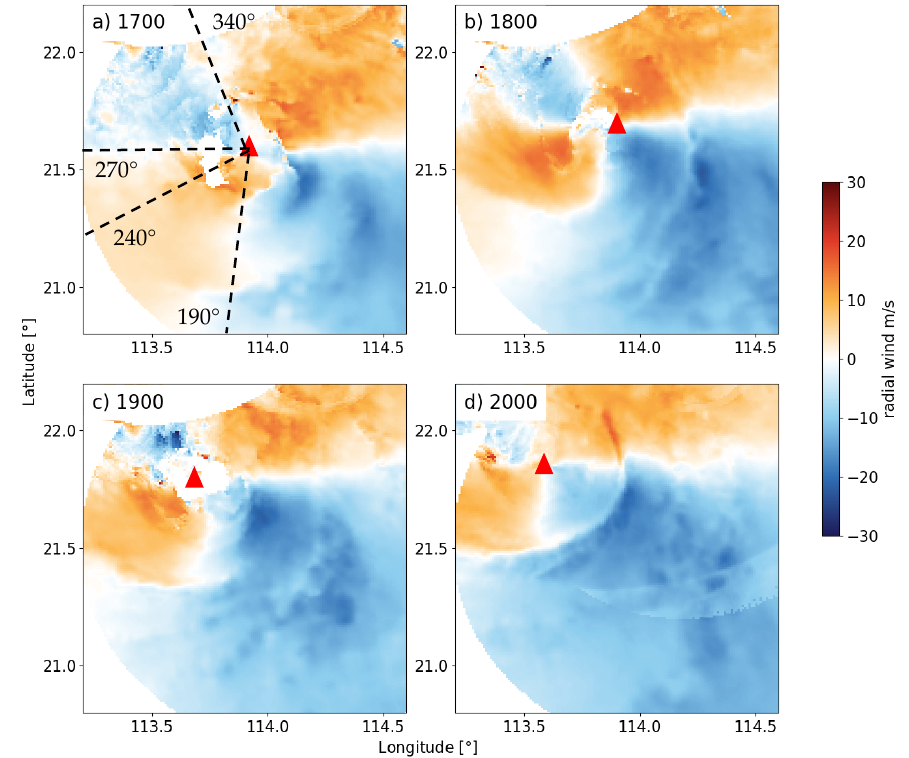
Figure 9. Radial wind calculated based on the horizontal wind at 4 km altitude in Figure 8 with the typhoon center as polar coordinate center point at ( a ) 17:00, ( b ) 18:00, ( c ) 19:00 and ( d ) 20:00 UTC on 18 August 2020. The red triangle represents the typhoon center; the cool color and warm color represent the inflow and outflow of the radial wind, respectively; and the dashed line marks the azimuth positions of the upwind and downwind of stratiform rainband in the outer rainband of Typhoon Higos.